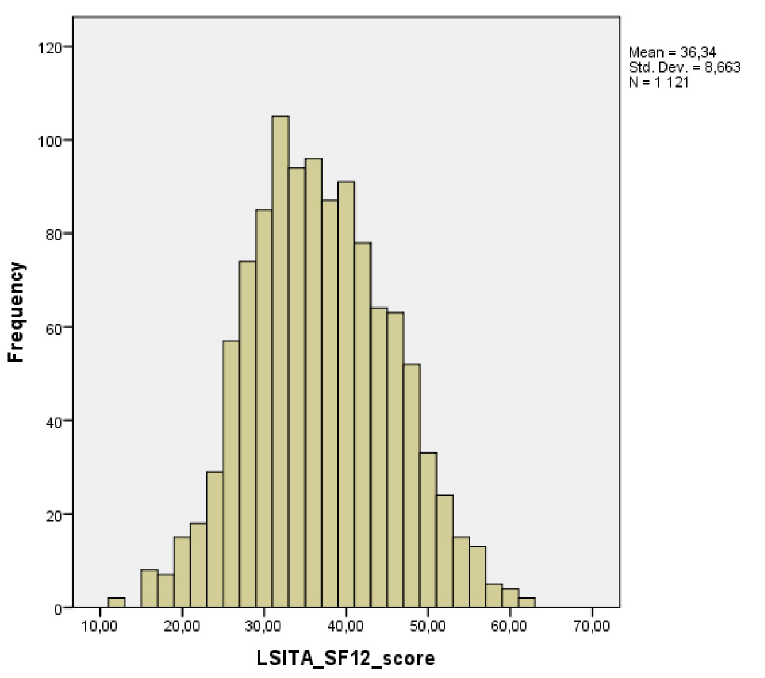
Fig 1. Contribution of LSITA_SF12